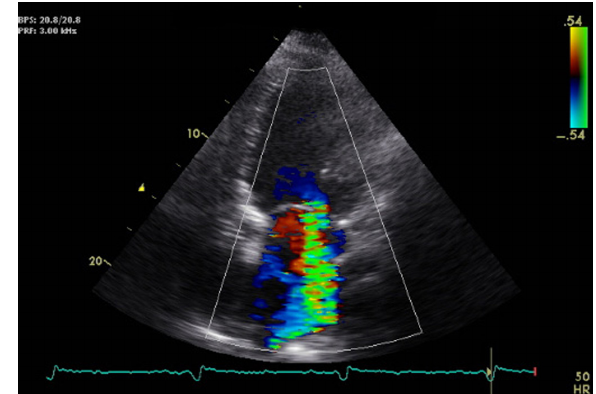
Figure 2 . Pre-procedural echocardiogram with bi-atrial dilatation.